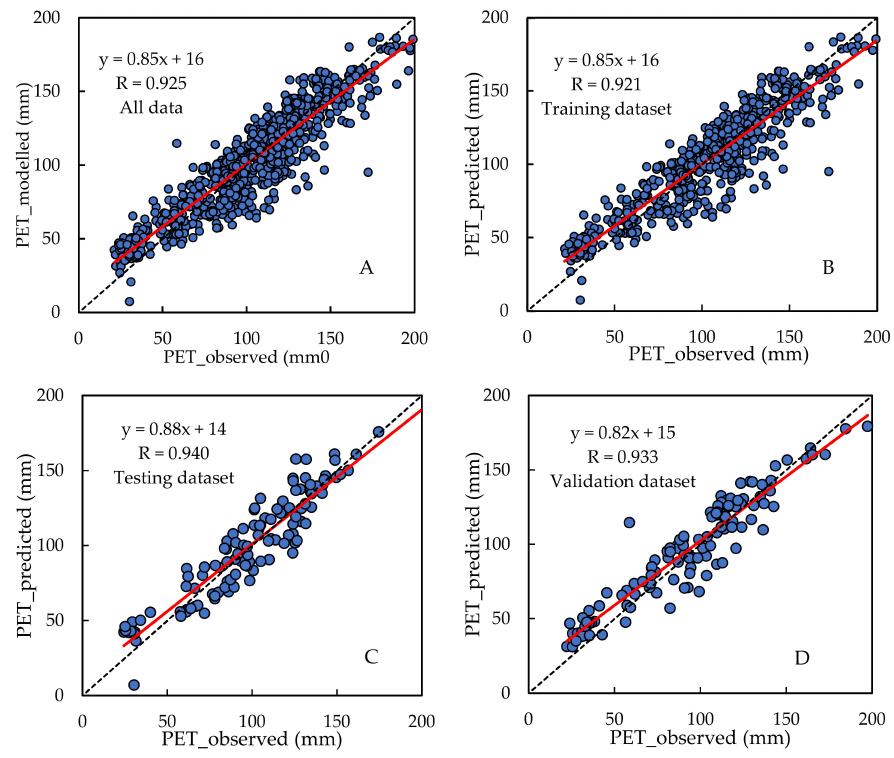
Figure 4. ANN model performance of adjusted MODIS-16 PET from different dataset: using all dataset ( A ); only from training dataset ( B ); testing dataset ( C ), and validation dataset ( D